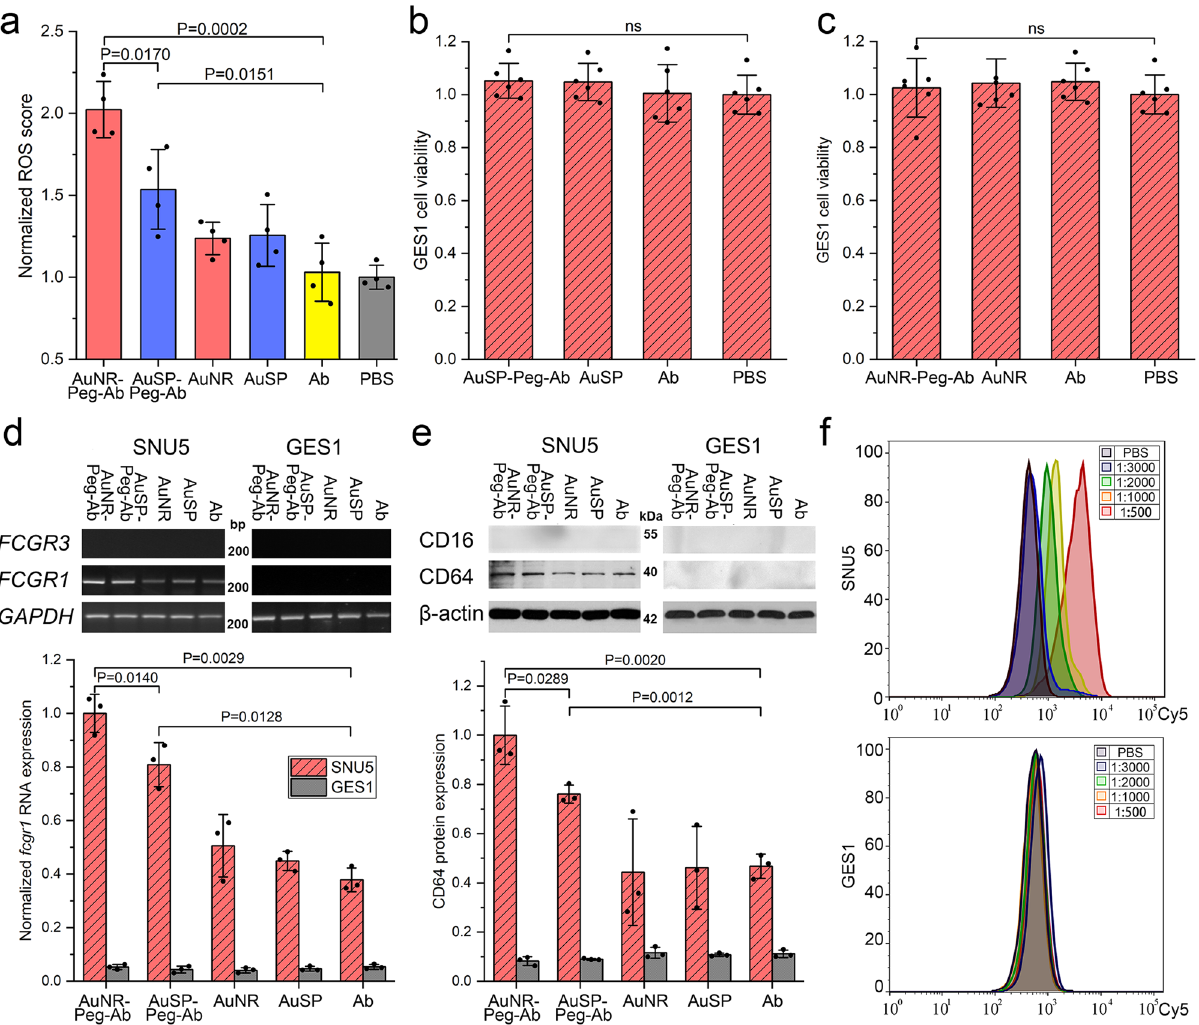
Fig. 6 The potential course of gold nanoparticles induced tumor cytotoxicity. a ROS generation test of SNU5 cell. Data represent mean ± SD ( n = 4). b , c Cell viability analysis in GES-1 cell treated by different material. Data represent mean ± SD ( n = 6). d , e mRNA and protein expression level CD64 in SNU-5 and GES-1 cells. Data represent mean ± SD ( n = 3). f Flow cytometry analysis of Ab in SNU5 and GES1 cells. PEG was omitted in the mark of the nanodrug complex. Statistical difference was evaluated by one-way ANOVA followed by Tukey ’ s post hoc